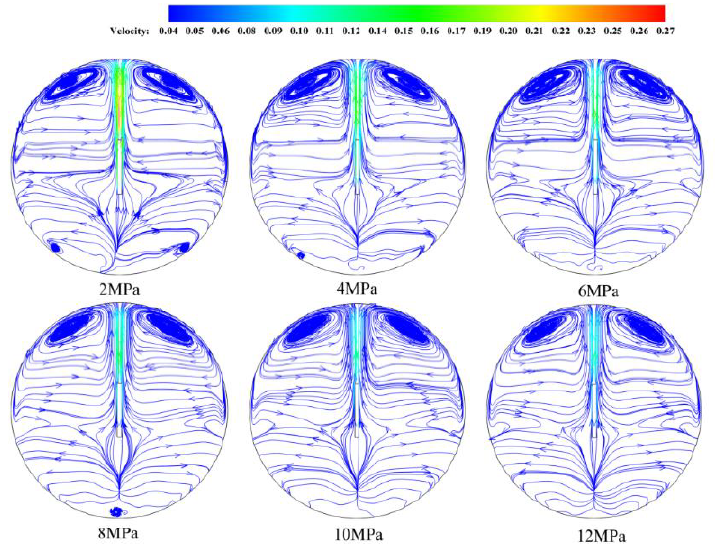
Figure 9. Velocity contour and streamline of the supercritical helium under different